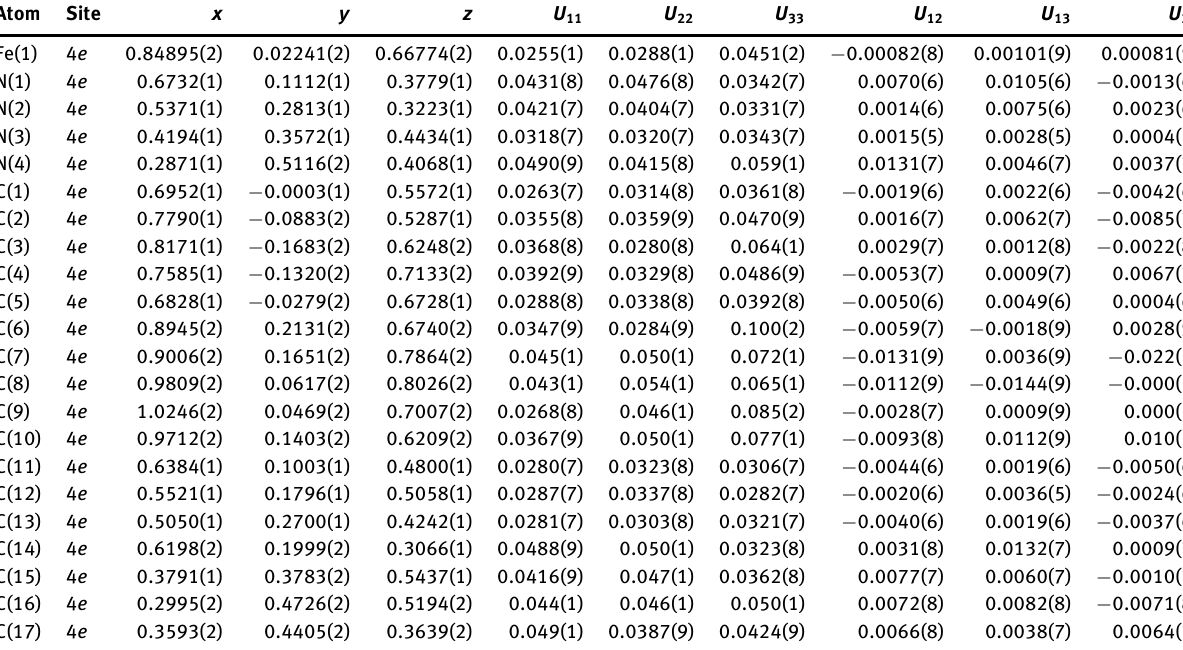
Table 3: Atomic displacement parameters (Å 2